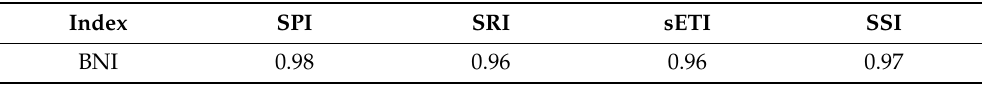
Table 3. The correlation coefficient between the monthly BNI and the monthly SPI, SRI, sETI and